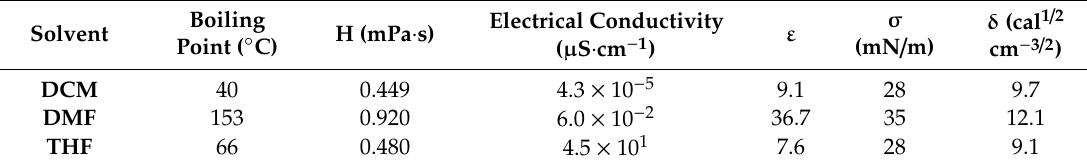
Table 1. Solvent properties used to dissolve the Polylactic acid. Viscosity is represented by η , ε is the dielectric constant, surface tension is σ , and δ is the solubility